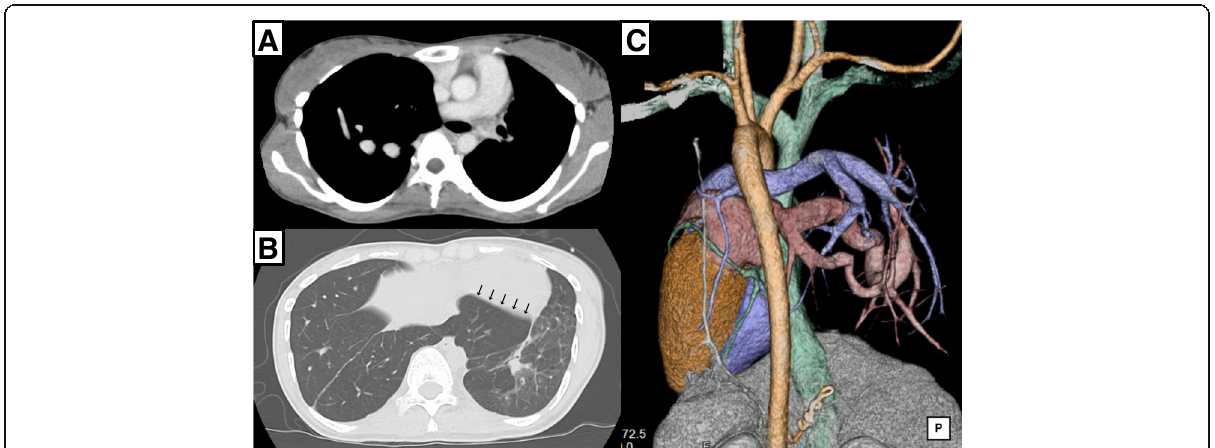
Fig. 1 a Left pulmonary artery (PA) branching from main PA was absent. b Right lung partially invaded into left thorax ( arrows ), and left lung contained both fibrous and bullous lesions. c Three-dimensional reconstruction image of the posterior aspect of the heart and major vessels indicated that neither PA ( blue ) nor pulmonary vein (PV) ( red ) was present in the left lung, while marked dilations of both PA and PV were seen in the right